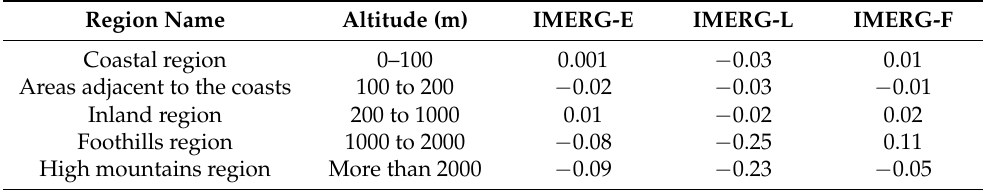
Table 7. RBIAS measurements for IMERG-E, IMERG-L, and IMERG-F using the topographical-based